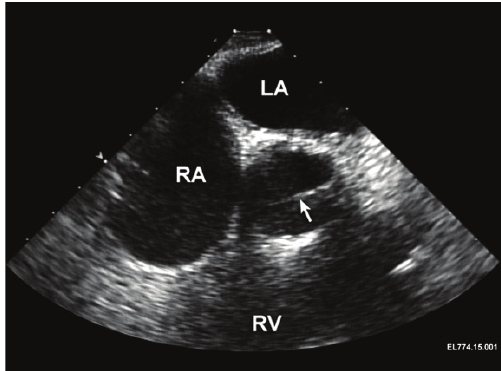
Figure 3: Intraoperative transesophageal echocardiographic view prior to replacement of the aortic valve prosthesis. This mides- ophageal aortic valve short axis view during systole demonstrates the normal open position of one of the mechanical aortic valve leaflets (arrow). The left atrium (LA), right atrium (RA), and right ventricle (RV) are also identified.